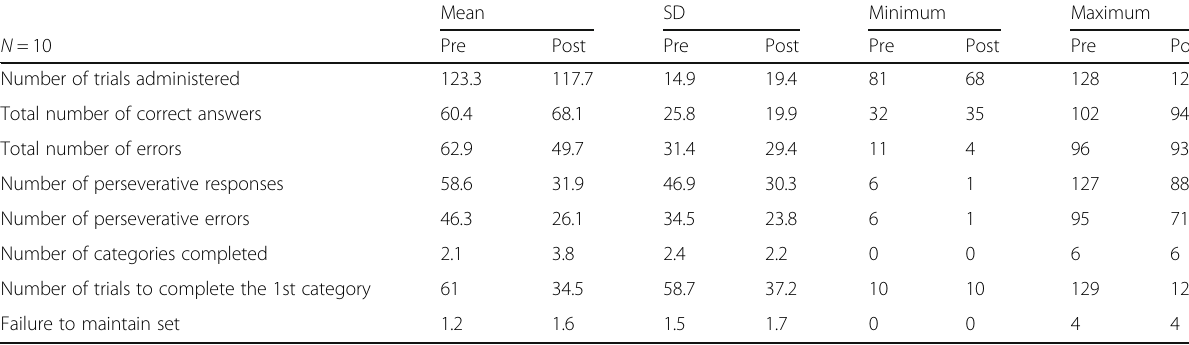
Table 3 Measures of central tendency in Wisconsin Card Sorting Test — WCST of the ten subjects in pretest and posttest Mean SD